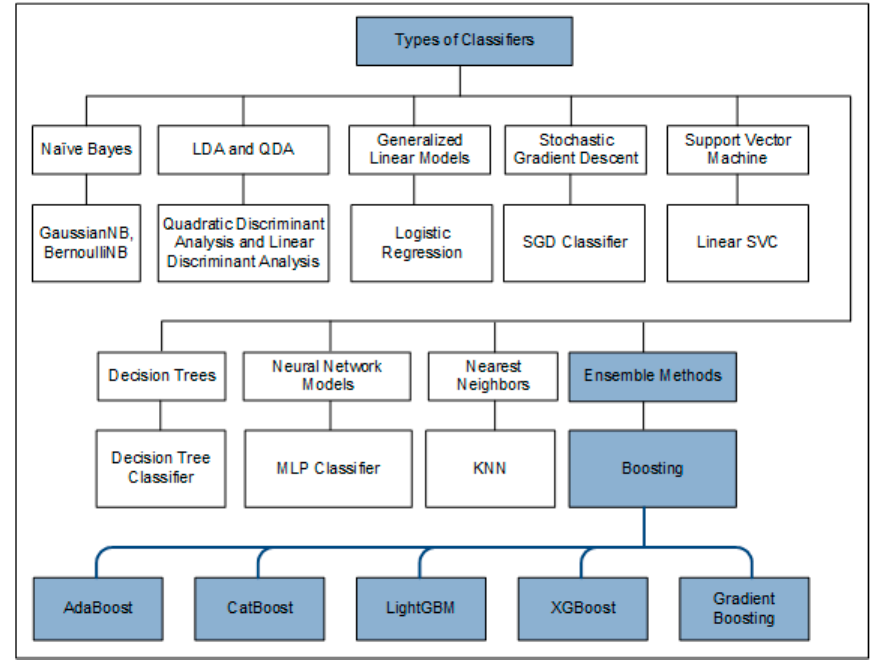
Figure 1. Basic types of supervised machine learning algorithms .